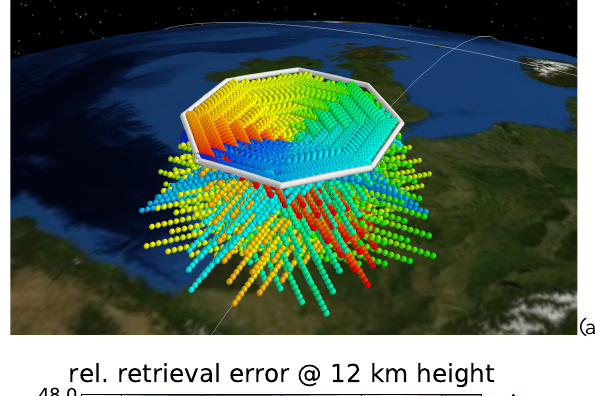
Fig. 13. The retrieval results for 12km height of all 1-D retrievals shown as color-coded circles placed at the horizontal location of the closest tangent point. The data point highlighted by a broad black circle has been selected for closer examination. The background shows the true state of the atmosphere.